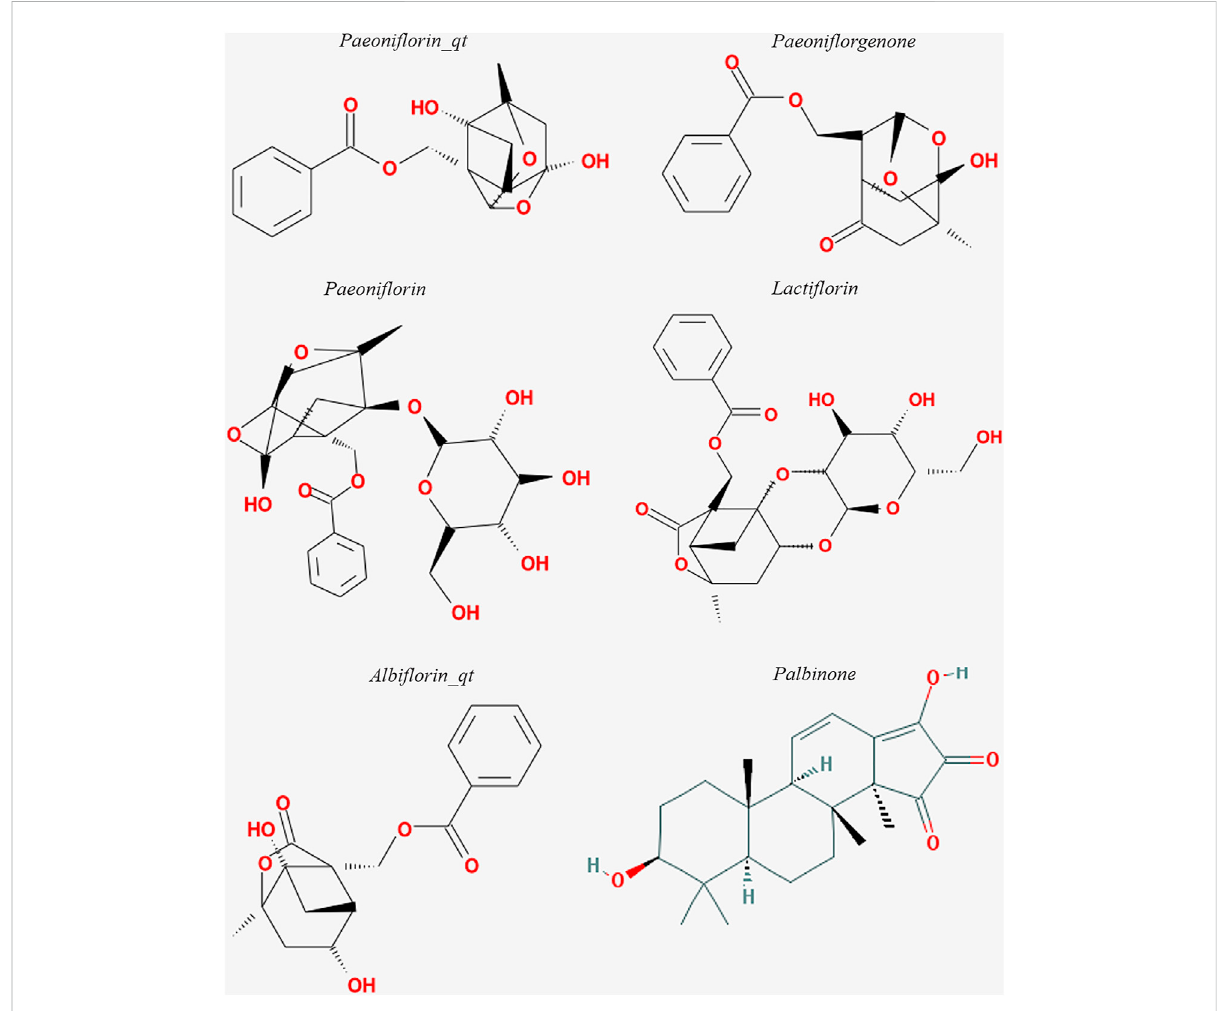
FIGURE 2 Structures of the six active compounds in Paeoniae Radix